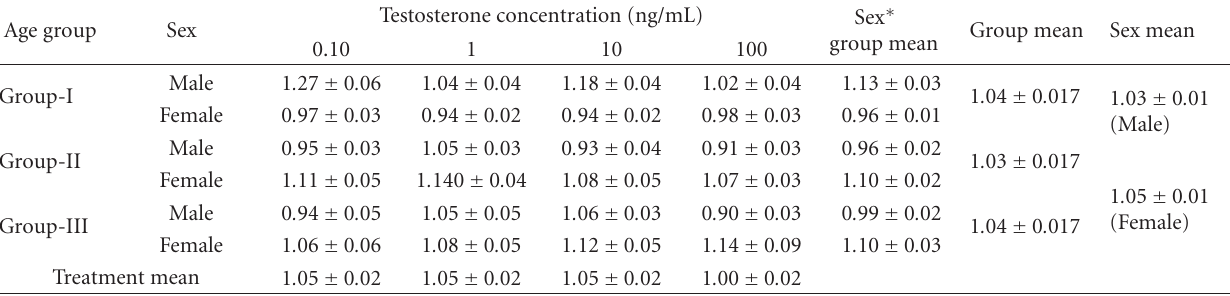
Table 3: Dose-dependent e ff ect of testosterone on lymphocyte proliferation in vitro in bu ff aloes of di ff erent sex and